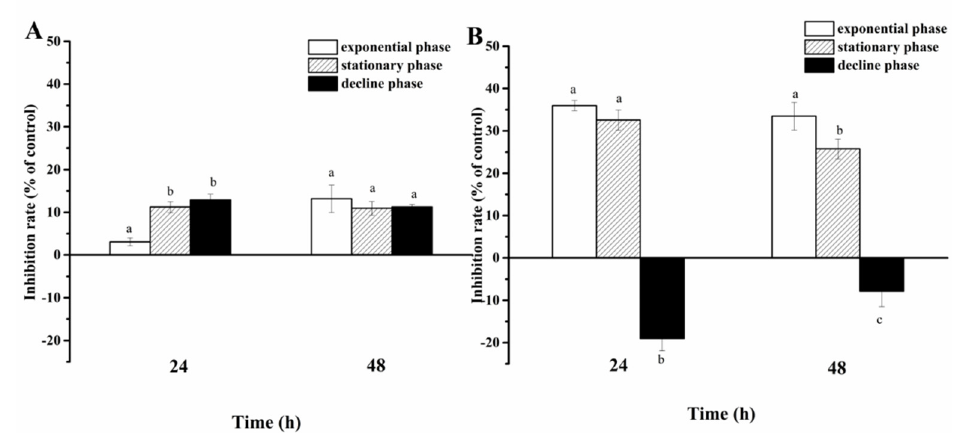
Figure 4. Inhibition rates of Akashiwo sanguinea JX14 at different growth phases on Rhodomonas salina CCMP1319. ( A ): cell-free filtrate of A. sanguinea JX14; ( B ): cell pellet of A. sanguinea JX14. Corresponding concentration and initial cell density of A. sanguinea JX14 and R. salina were 4000 cells mL − 1 and 1500 cells mL − 1 , respectively. Results are expressed in triplicate ± standard deviation (SD). Different lower-case letters (a, b, c) indicate significant difference ( p < 0.05) between treatments at the same time.